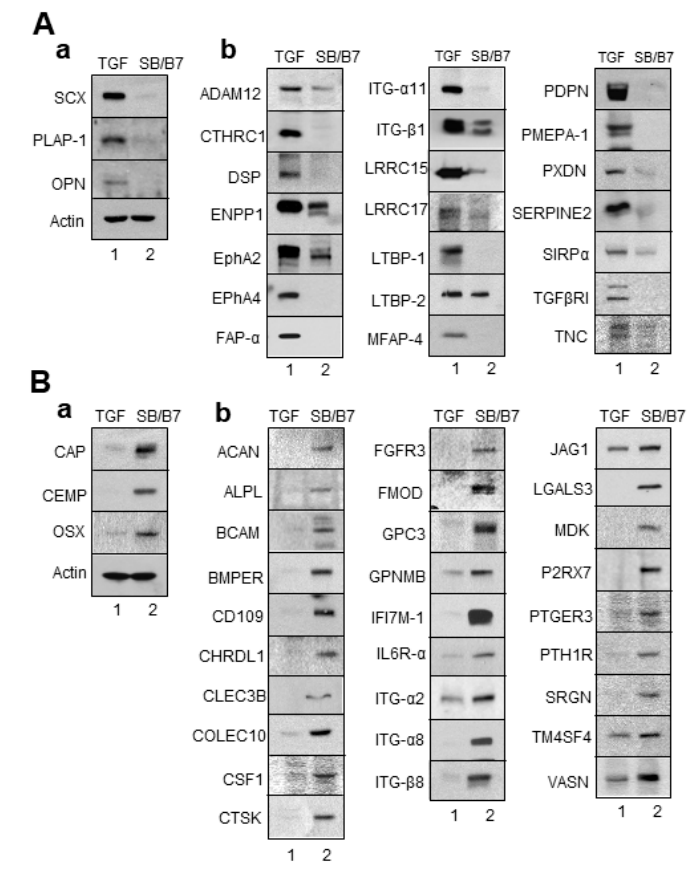
Figure 7. Validation of the expression of DEGs by Western blot analysis. Total cell extracts were obtained from progenitor cells and immunoblot analysis was performed with the primary antibod- ies. ( A ) The selected genes upregulated by TGF- β 1 treatment were confirmed by Western blot anal- ysis. ( B ) The selected genes upregulated by SB431542 and BMP7 treatment were confirmed by West- ern blot analysis. ( a ), immunoblots of the already known markers; ( b ), immunoblots of the selected upregulated DEGs. Lane 1, cell extract of hPDLCs treated with TGF- β 1; lane 2, cell extract of hPDLCs treated with SB431542 and BMP7.